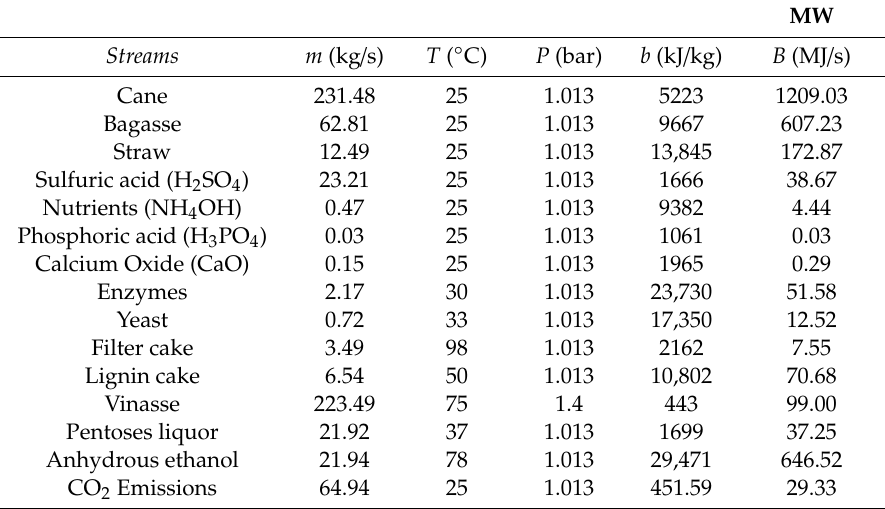
Table A17. Key streams parameters of the mass and heat-integrated system (1G2G-HI).